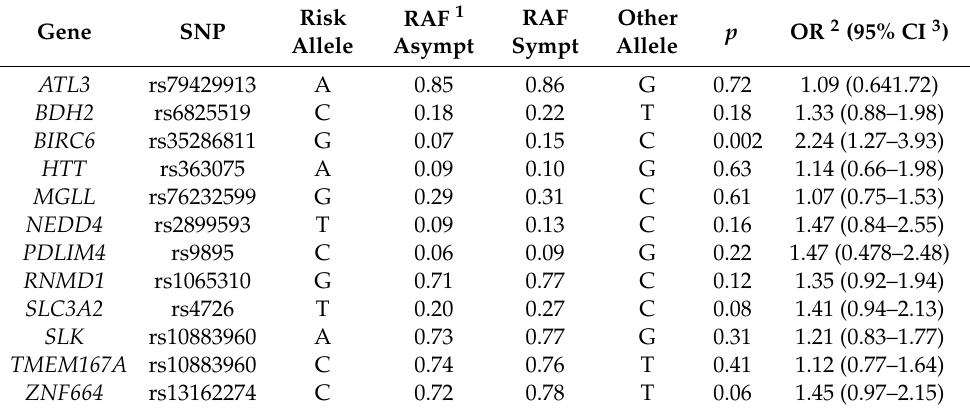
Table 3. Association values of candidate SNPs related with symptomatology of carotid atherosclerosis in validation cohort (n = 301, 169 asymptomatic and 132 symptomatic). 1 RAF: risk allele frequency. 2 OR: odds ratio. 3 CI: confidence interval.